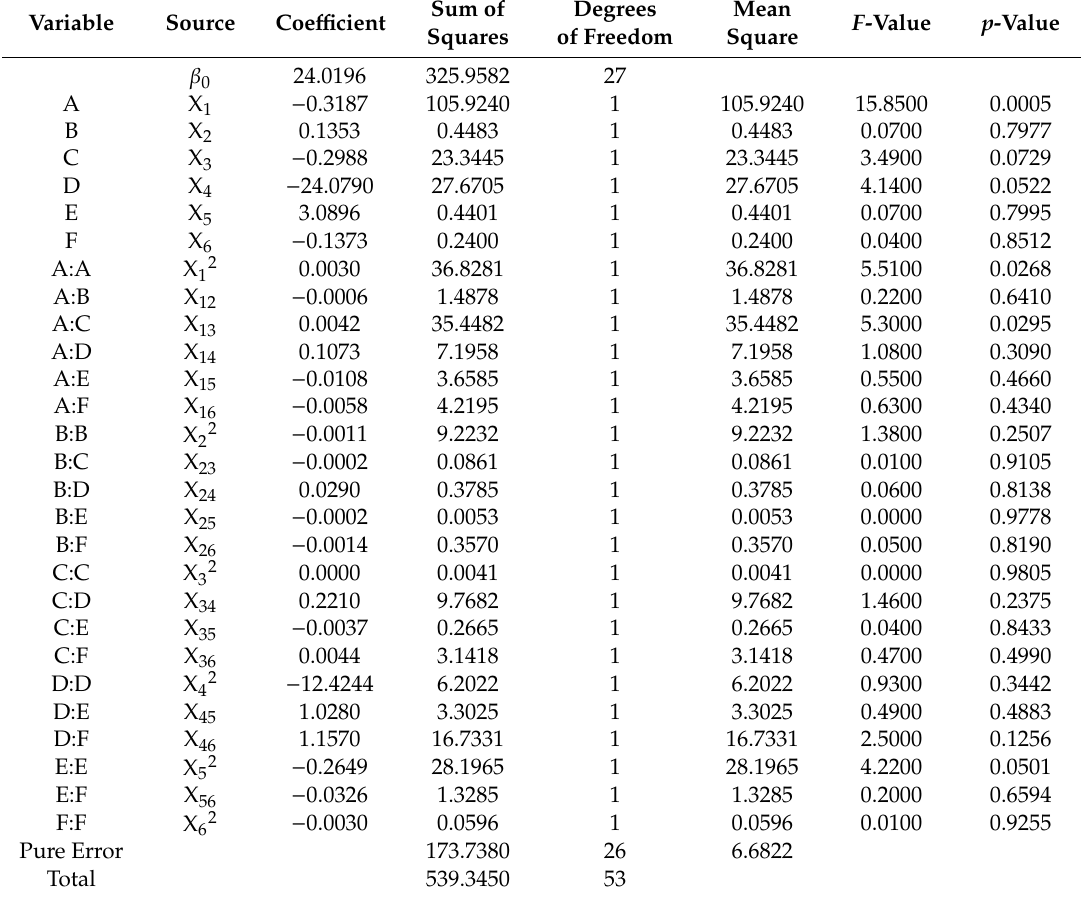
Table 3. Analysis of variance of the quadratic model adjusted to the extraction of